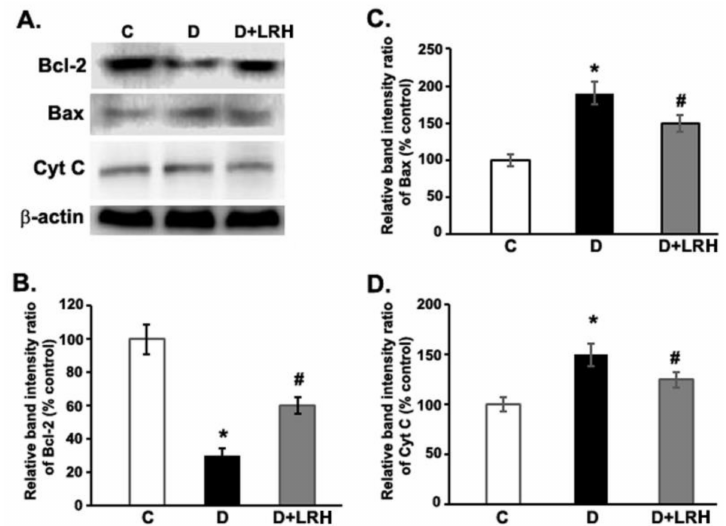
Figure 4. L. regularis ameliorated anti-apoptotic and pro-apoptotic proteins expression in the diabetic rat retina. Densitometry was used to measure the band intensities after Western blotting. Bcl-2, Bax, Cyt C, and β -actin immunoblots are shown in Panel ( A ). Band intensity ratios of Bcl-2 protein bands (Panel ( B )), Bax protein bands (Panel ( C )), and Cyt C protein bands displayed as a percentage of control (Panel ( D )). The values are means ± SEM for six determinations. * p < 0.01 shows a remarkable variation from their controls; # p < 0.05 shows significantly different from diabetic retinas.